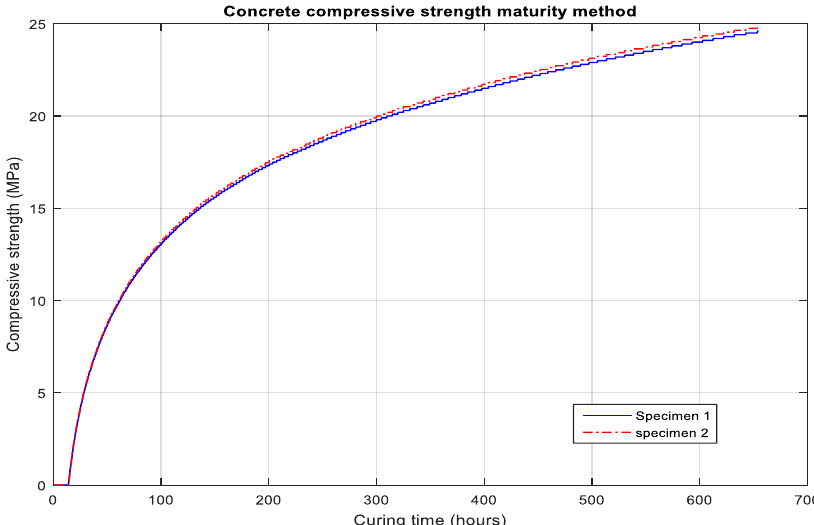
Figure 10. Concrete compressive strength data from temperature sensors.